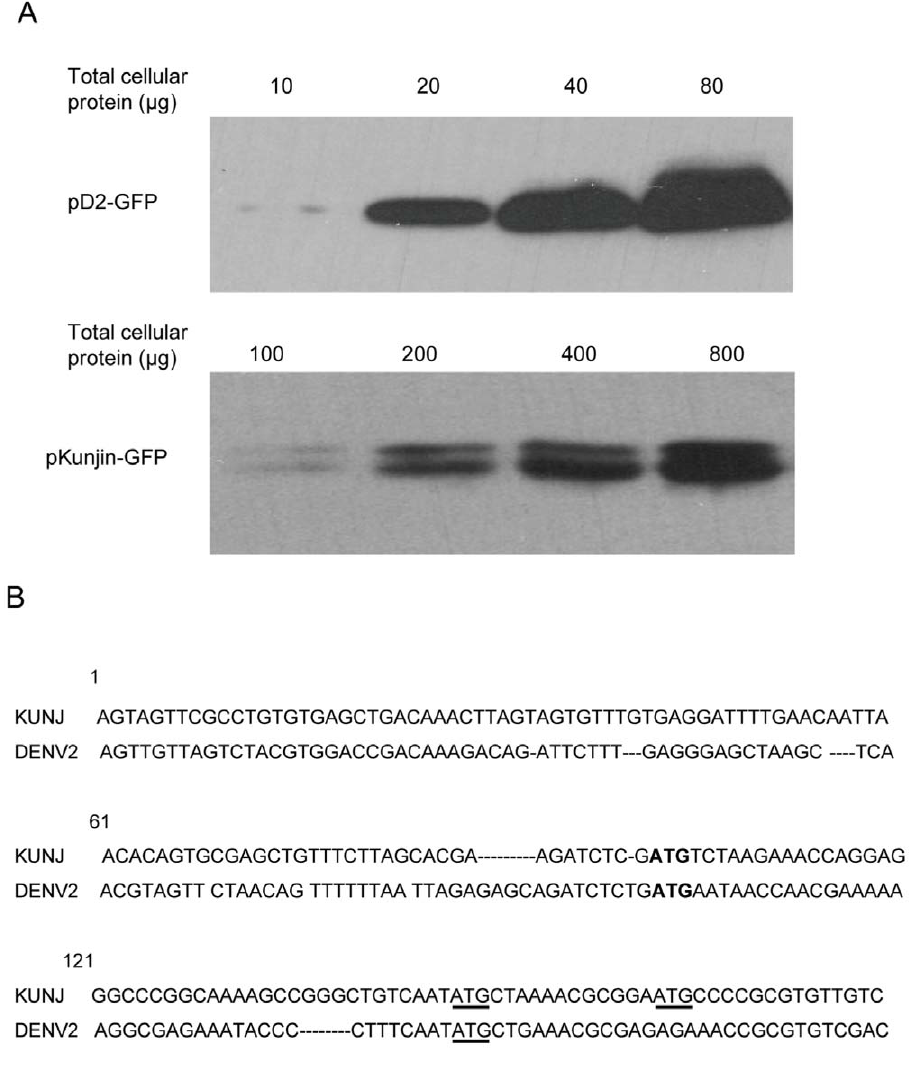
Figure 5. 5 9 cDNA sequence of Kunjin virus genome also contains an active cryptic bacterial promoter. (A) Western blots of cell lysates of E. coli cells transformed with pD2-GFP and pKUN-GFP probed with an anti-GFP antibody. (B) A comparison of cDNA sequences encoding the 5 9 portion of the KUN and DENV2 genomes. The ATGs encoding the authentic viral initiation codons are shown in bold. The ATGs encoding codons utilised by E. coli for translation initiation are